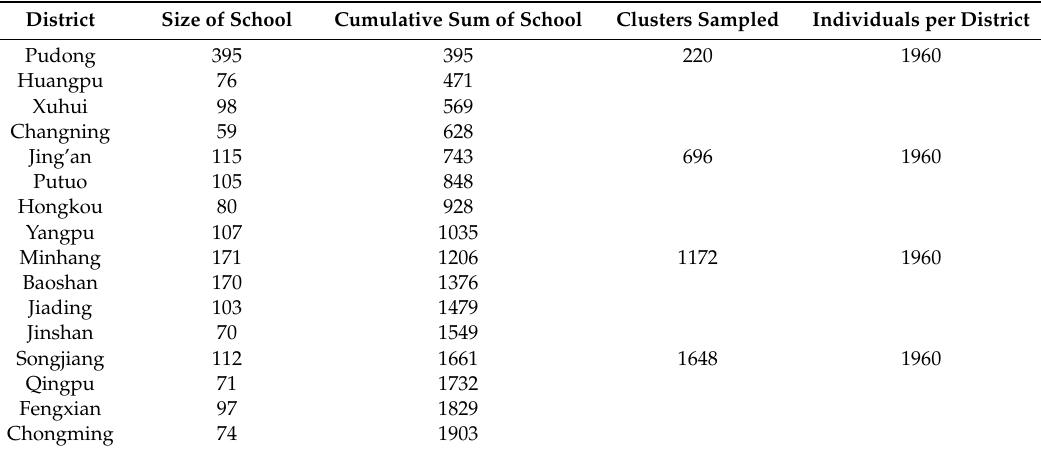
Table 3. PPS sampling of at the first stage for school